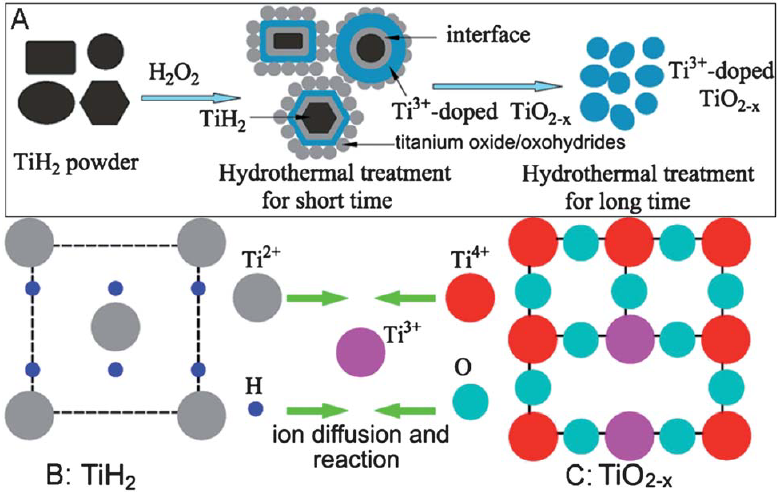
Figure 5. ( A ) Scheme of the formation mechanisms for the rice-shaped Ti 3+ self-doped titania nanoparticles. ( B , C ) The interface diffusion–redox diagram. Reprinted with permission from [31] Copyright 2013, The Royal Society of Chemistry.